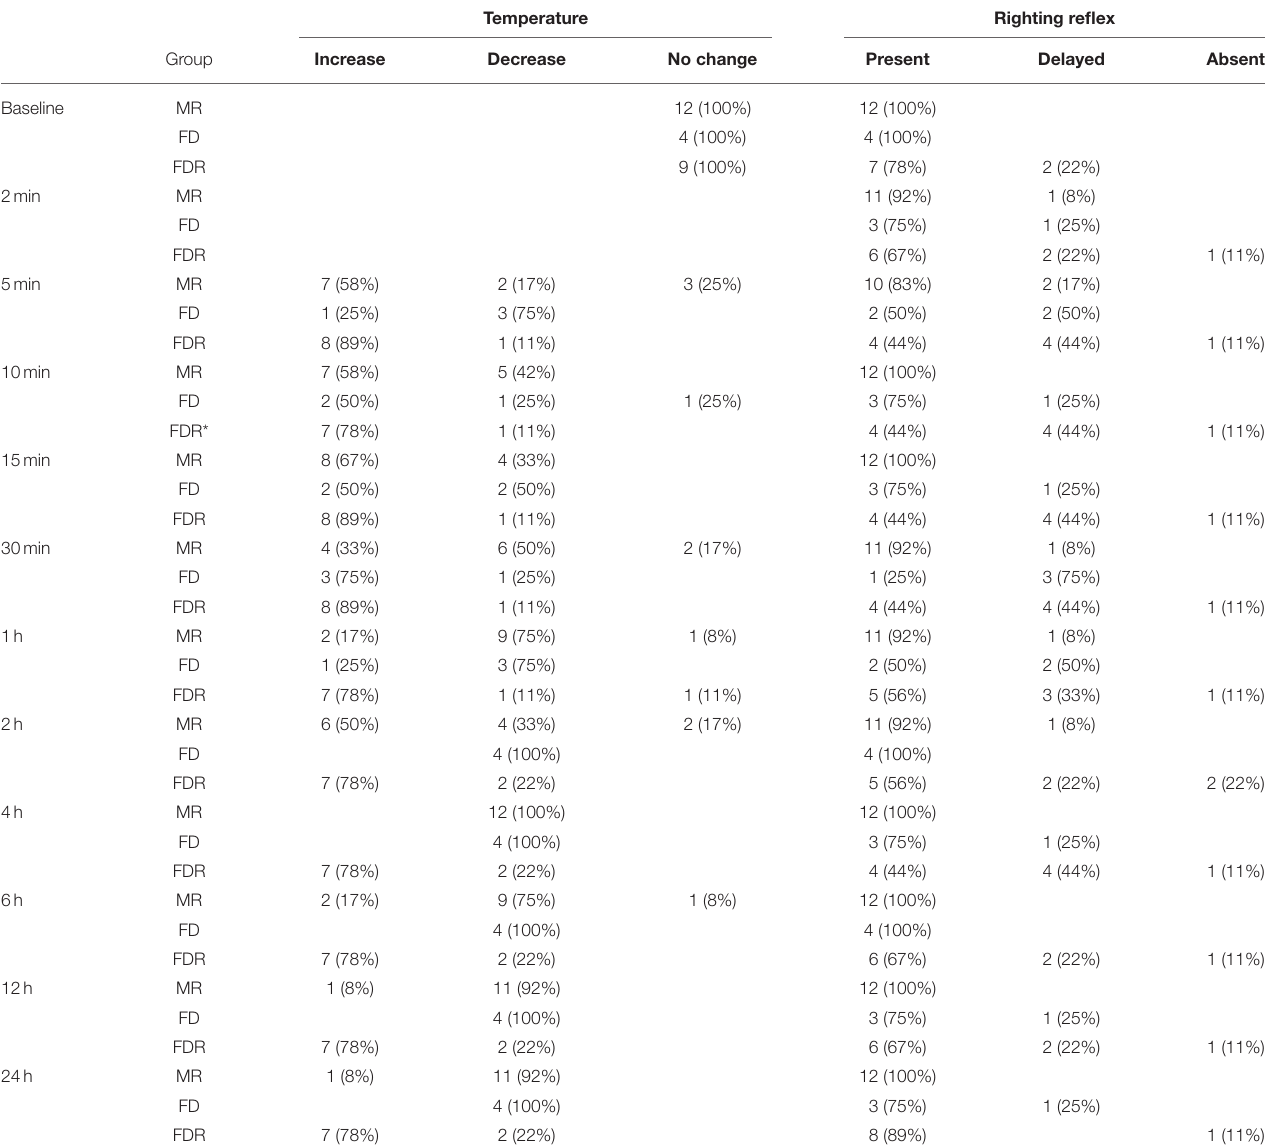
TABLE 2 | Number (percentage) of male serum recipient (MR), female serum donor (FD), and female serum donor and recipient (FDR) thorny devil stick insects ( Eurycantha calcarata ) with a change in surface temperature (increase, decrease, no change) and righting reflex (present, delayed, absent) prior to and following injection with homologous serum (MR, FDR) and/or lactated Ringer’s solution (FD, FDR); * denotes a missing